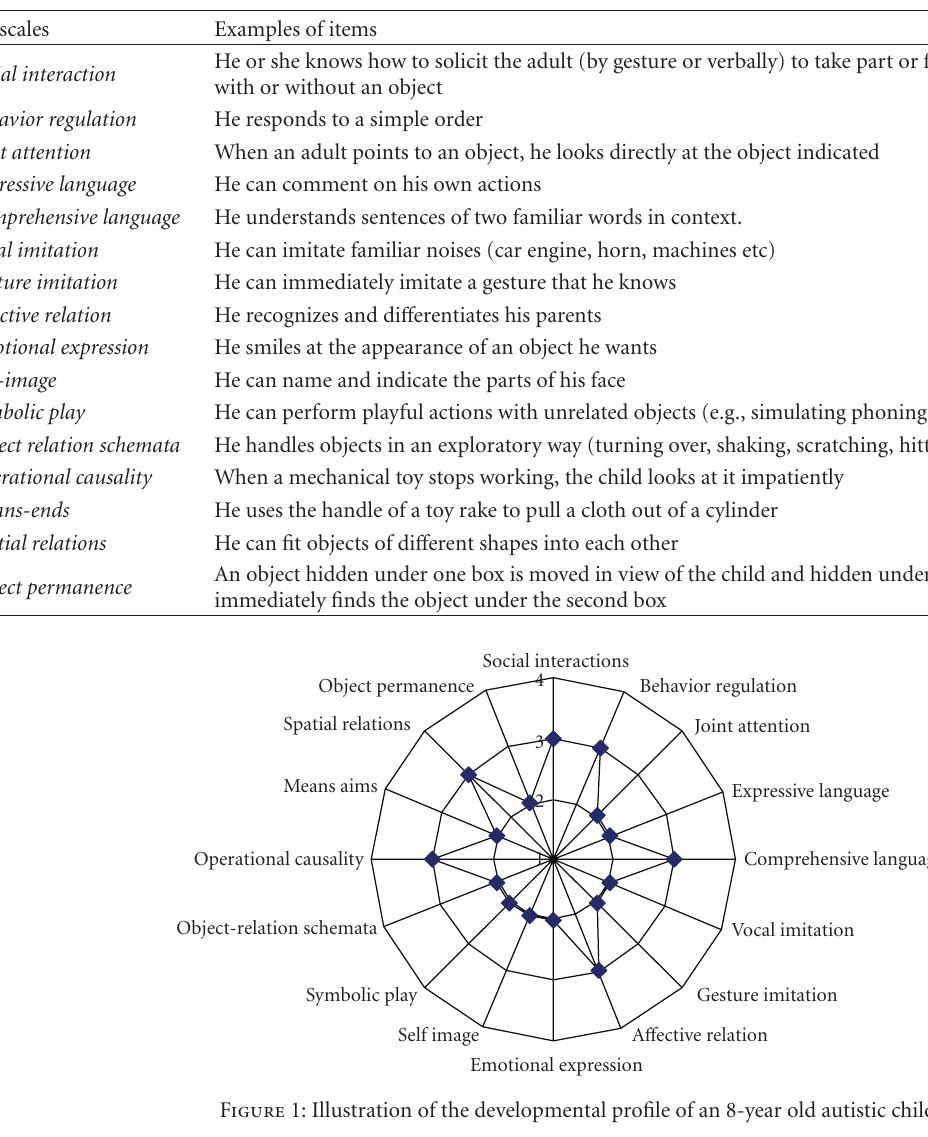
Table 1: Examples of items taken from the 16 developmental level scales of the SCEB.